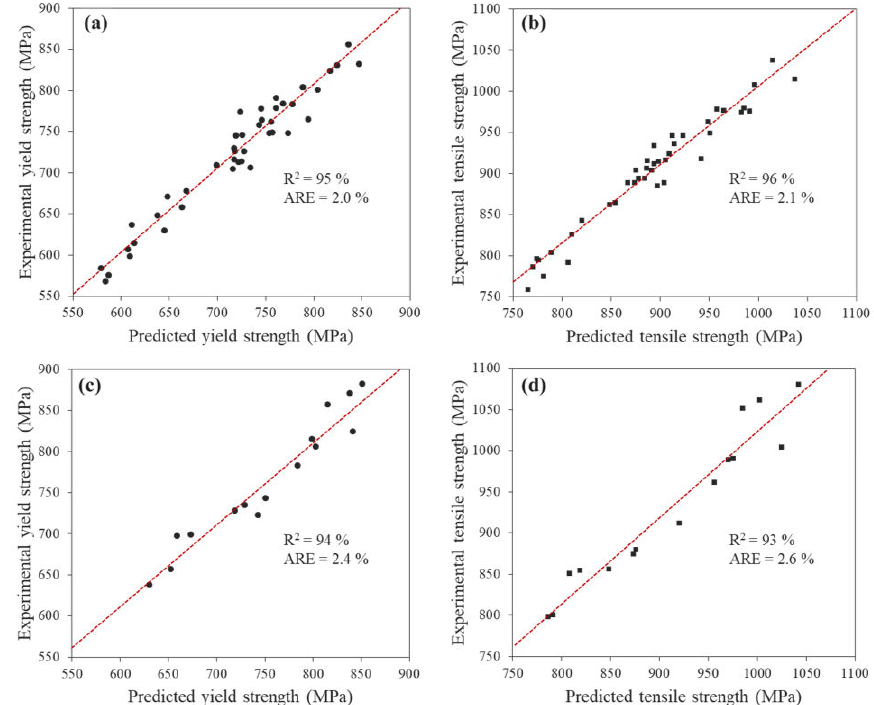
Figure 9. Comparison of experimental strength data with the ANN prediction lines: ( a , b ) yield and tensile strengths using the training set, ( c , d ) yield and tensile strengths using the testing